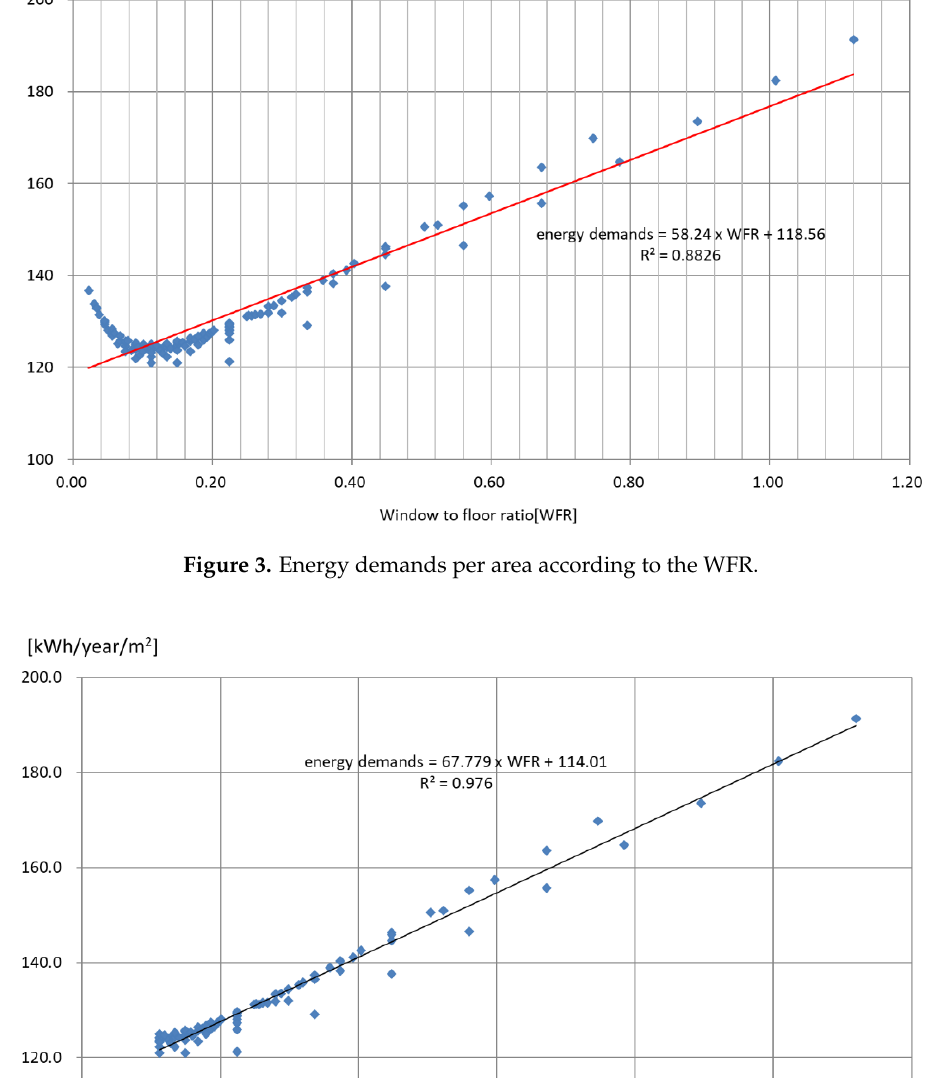
Figure 4. Energy demands per area when WFR ≥ 0.1.